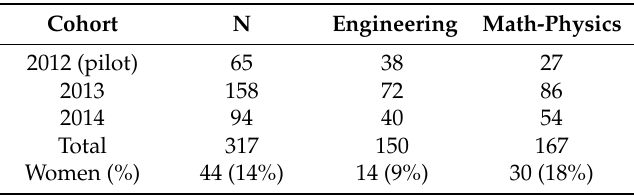
Table 1. Participation rates by sample, field and